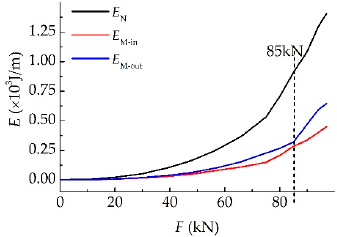
Figure 7. The curves of generalized energy densities for axial force and bending moments.